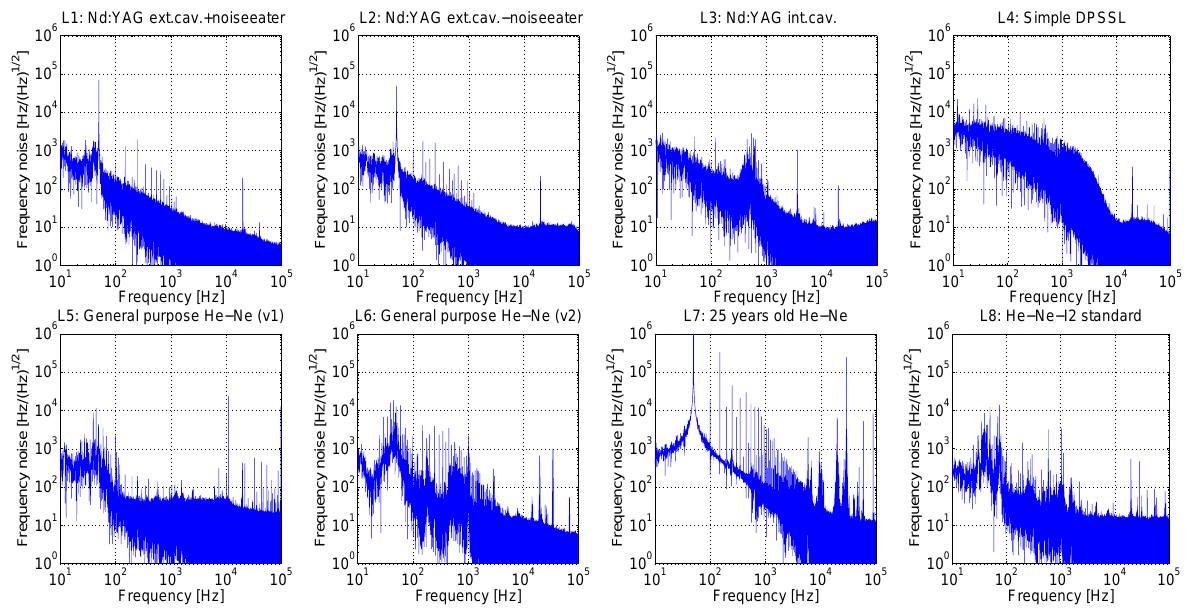
Figure 5. Frequency noise measurements of tested laser heads (Fabry-Perot cavity).